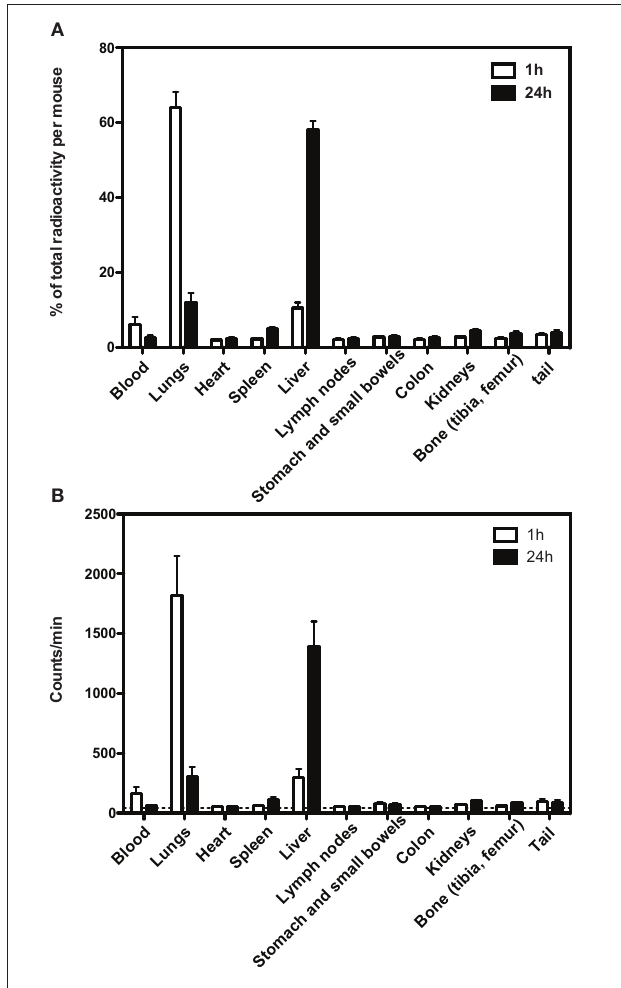
FIGURE 2 | Distribution of Cr-51 radioactivity after infusion of Cr-51 labeled DsRed-MSC. (A) One hour after intravenous injection, more than 60% of total radioactivity is located in the lungs and approximately 10% in the liver. Other tissues contain only residual radioactivity. After 24h, the majority of radioactivity is located in the liver. (B) As in (A) , but absolute counts shown. Dashed line indicates background radioactivity. Cervical, axillary, inguinal, hepatic, para-aortal, and mesenteric lymph nodes were collected. Average data of 2 experiments is